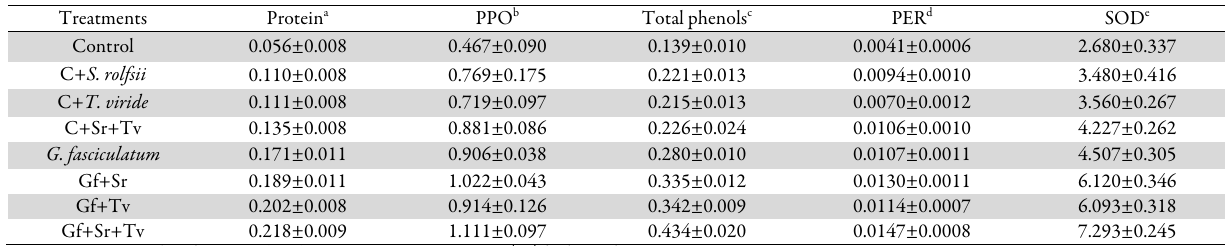
Table 2. Biochemical and antioxidant enzyme activities in leaves of groundnut (W-51) due to inoculation of G. fasciculatum and T. viride